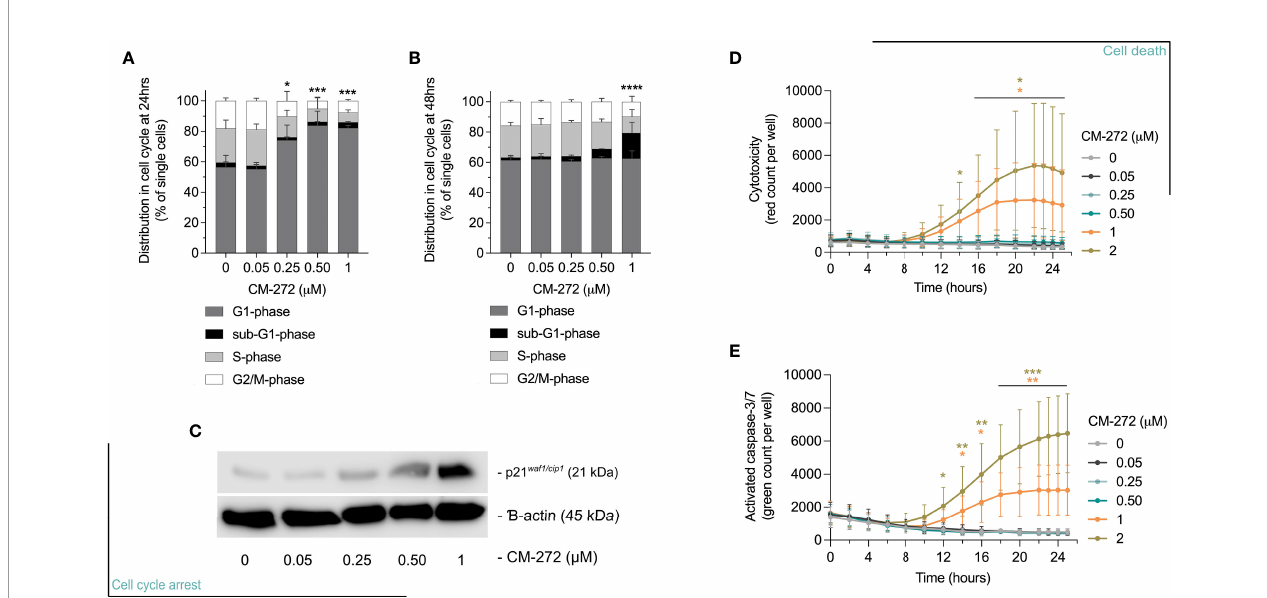
FIGURE 2 | Dual G9a and DNMT inhibition causes MO4 cell cycle arrest and cell death. (A, B) Percentage of MO4 cells in cell cycle phases (mean ± SD; n = 4). Asterisks represent signi fi cant differences in (A) G1-phase at 24 hours or (B) sub-G1-phase at 48 hours. (C) p21 protein expression and ß-actin loading control (representative blot; n = 3). (D, E) Cell death induction: (D) Loss of cell membrane integrity and (E) caspase-3/7 activity in time (mean ± SD; n = 3). Vehicle and CM- 272 conditions were compared using ordinary one-way Anova and post-hoc Dunnett ’ s multiple comparison tests (A, B) or REML modeling with Geisser-Greenhouse correction and post-hoc Sidak multiple comparison test (D, E) . Asterisks indicate statistical signi fi cance: *p ≤ 0.05; **p ≤ 0.01; ***p ≤ 0.001; ****p ≤